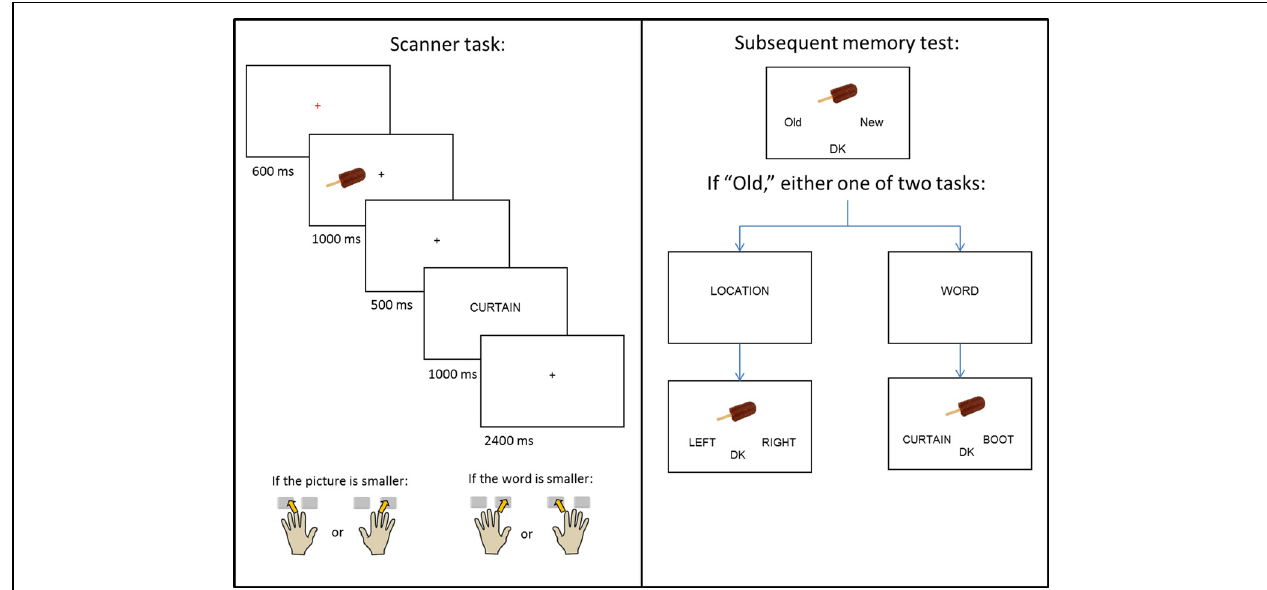
FIGURE 1 | Schematic of the experimental